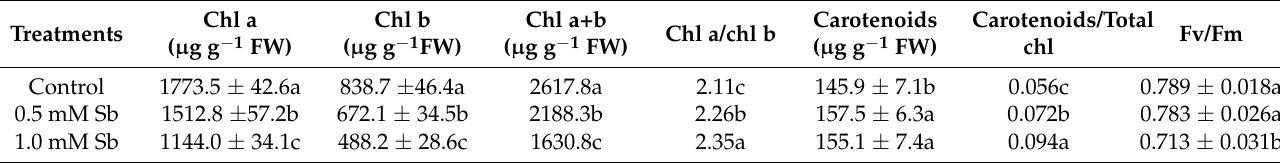
Table 4. Effect of Sb on the chlorophyll a and b and total chlorophyll contents ( µ g g − 1 FW), chlorophyll a/b ratio, total The data are from 10 independent experiments, each carried out in triplicate (different letters indicate significant differences at p < 0.05, Mann–Whitney